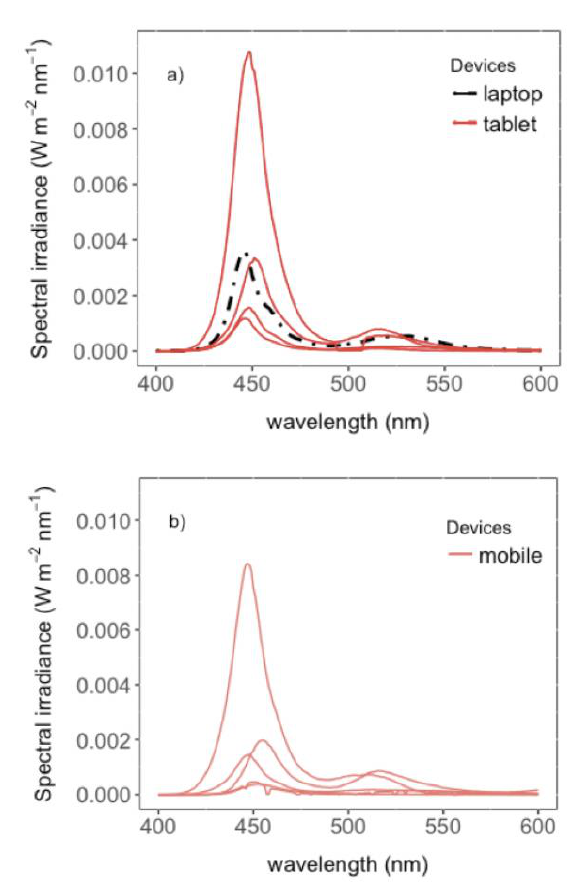
Figure 3. Spectral irradiances measured at 10 cm for different electronic devices: ( a ) One laptop and four electronic tablets; ( b ) five mobile phones.